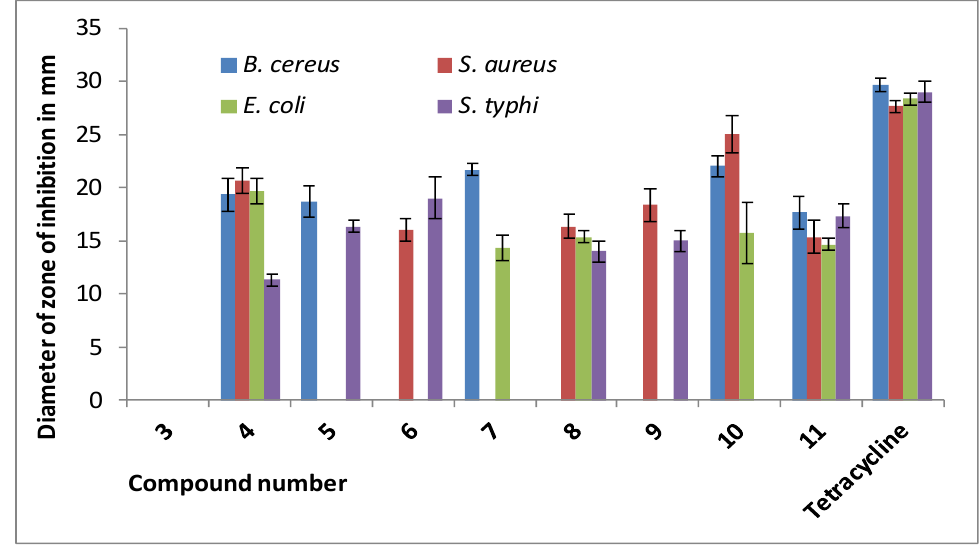
Figure 3. Inhibition against bacterial pathogens by the stearoyl rhamnopyranosides 4 – 11 .